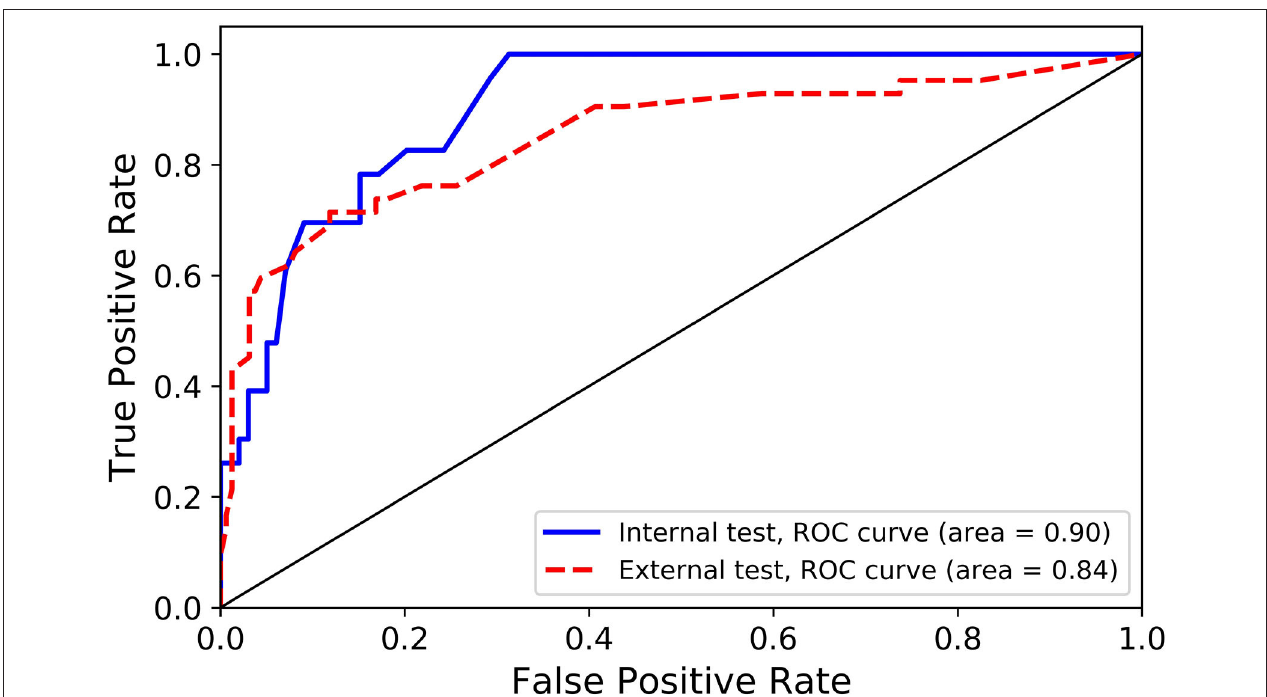
FIGURE 1 | Receiver operating characteristic (ROC) curves for internal and external independent